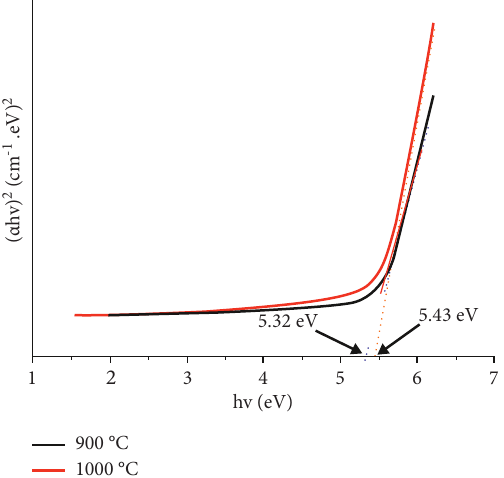
Figure 9: Energy gaps for CaTiO